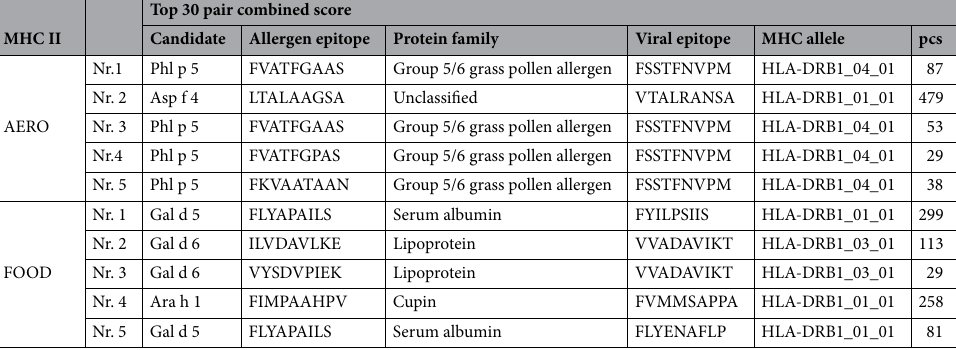
Allele HLA-I-Binding Peptide IC50 SARS-CoV-2 protein